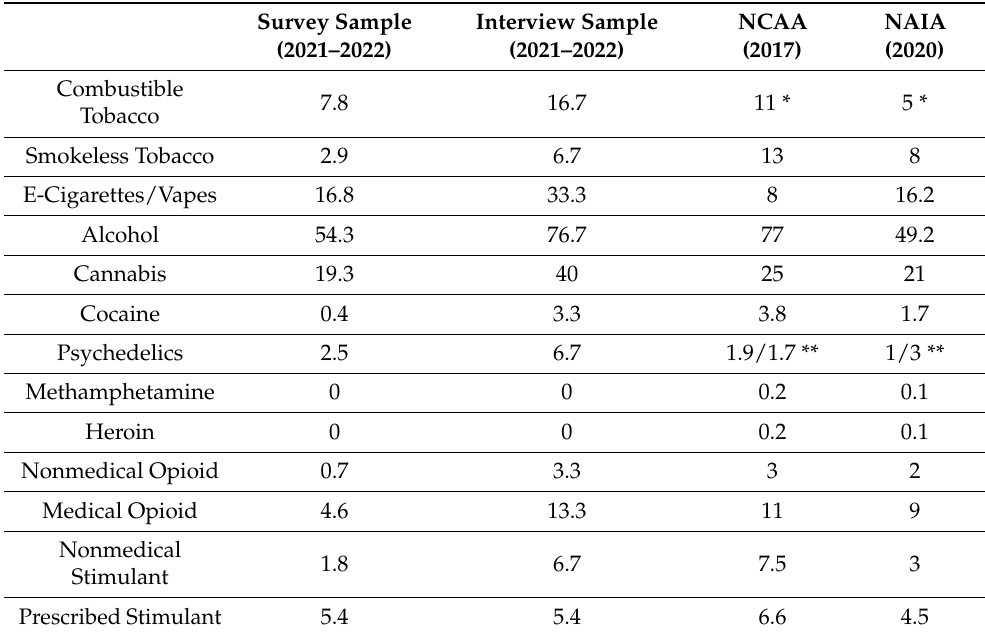
Table 2. The rates of Reported Past-Year Substance Use, by Type, and Study/Year (%). Survey